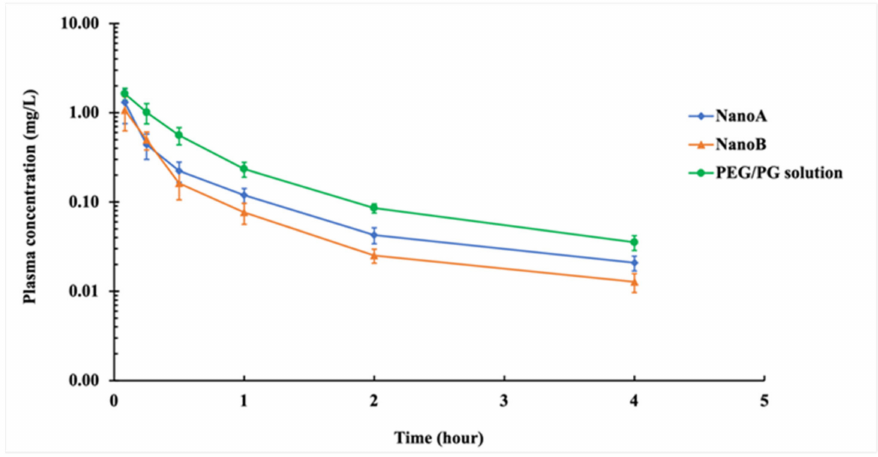
Figure 5. Plasma concentration–time curve of PEG/PG solution and NanoA and NanoB suspensions after intravenous administration in Sprague–Dawley rats at a dose of 2.5 mg/kg ( n =